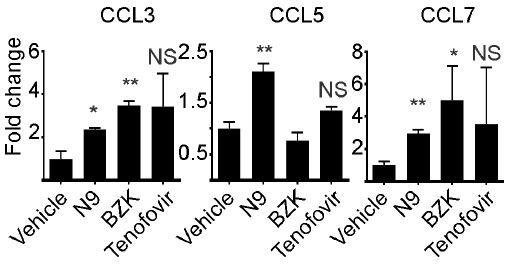
Figure 4. RT-PCR analysis of mouse CCL3, CCL5, and CCL7 gene expression. Relative expression levels are normalized to Glyceralde- hyde 3-phosphate dehydrogenase (GADPH). Statistical analysis was performed using a two-tailed Student’s T-test of N9, BZK, and Tenofovir samples (3 replicates) compared to vehicle controls (***=p # 0.001, **=p # 0.01,*=p # 0.05, NS=not